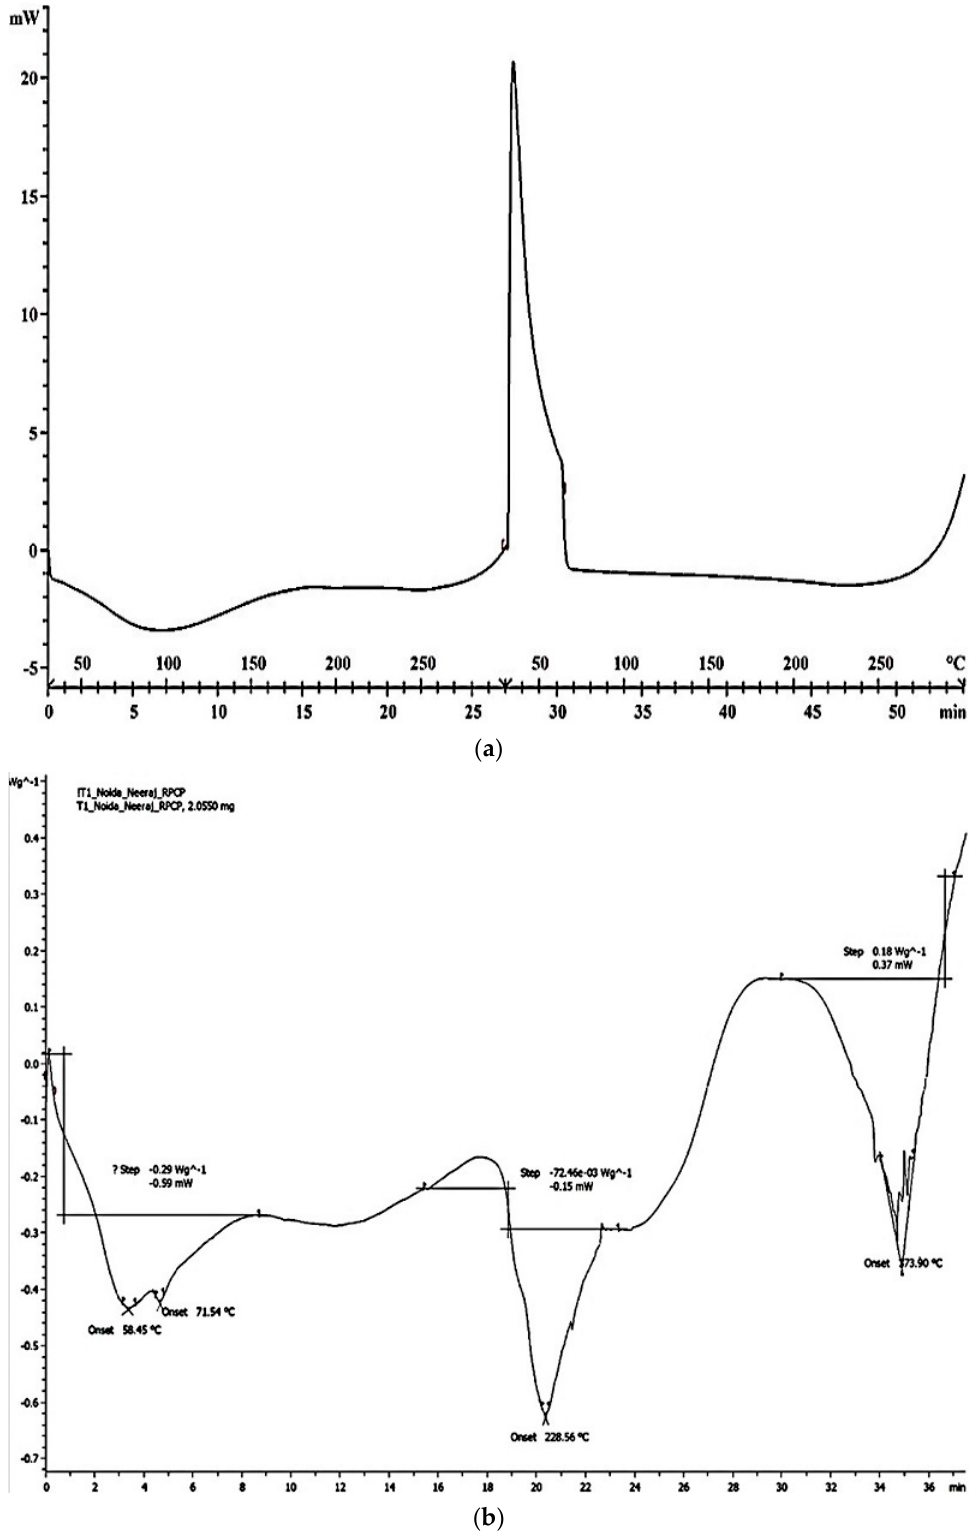
Figure 4. DSC of ( a ) TSP and ( b ) TSP-g-Am (F1) .